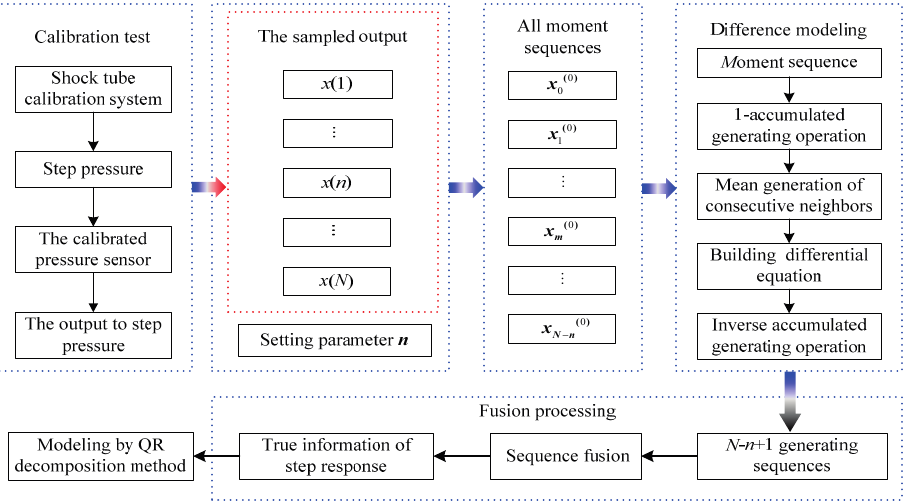
Figure 2. Principle for processing the dynamic calibration